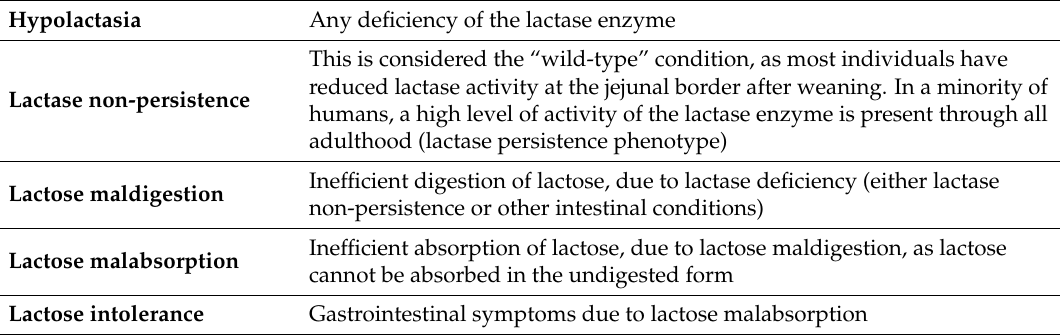
Table 1. Definition of hypolactasia, lactase non-persistence, lactose malabsorption, and lactose intolerance (modified from [14]).